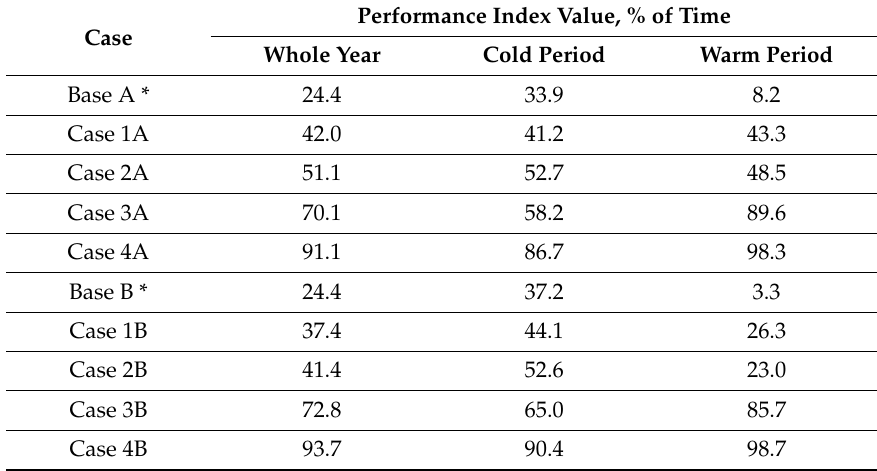
Table 5. The performance index for hourly values of the indoor relative humidity amplitude within ± 10% from the RH set